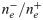
AUPR score of NN-MT and RN-MT as a function of the ne-/ne+ ratio, for a number of extra-task positive pairs ne+ varying from 0 to 50, and for percentile-based similarity threshold θ of 20 and 80 applied to the intra-task positive pairs.(a): NN-MT, θ = 0.20. (b): NN-MT, θ = 0.80. (c): RN-MT, θ = 0.20. (d): RN-MT, θ = 0.80. Numerical values can be found in Supporting Information, respectively S9–S12 Tables.